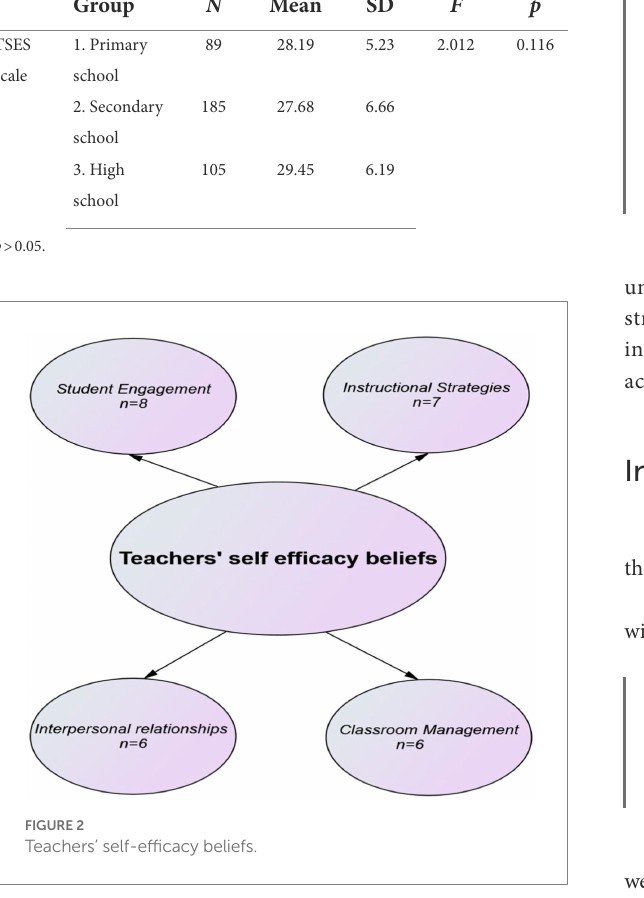
TABLE 6 “ANOVA test” results for “TSES” in regard to the school level. Group